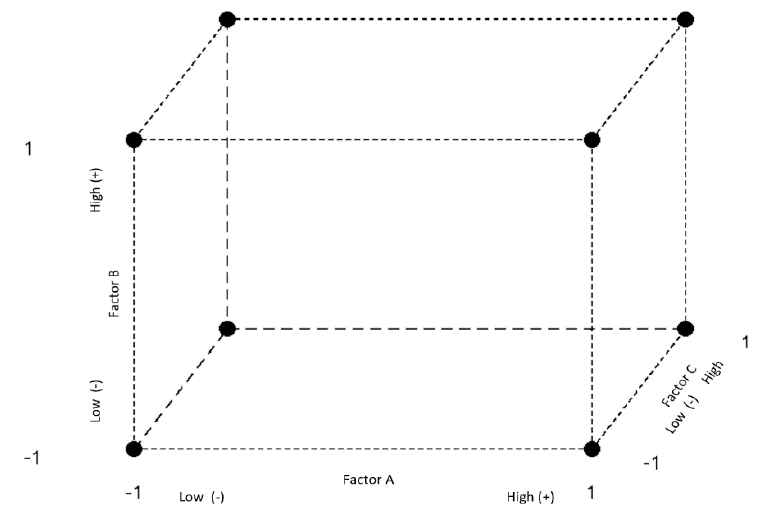
Figure 1. Geometric view of a general 2 3 design. Source: [20].